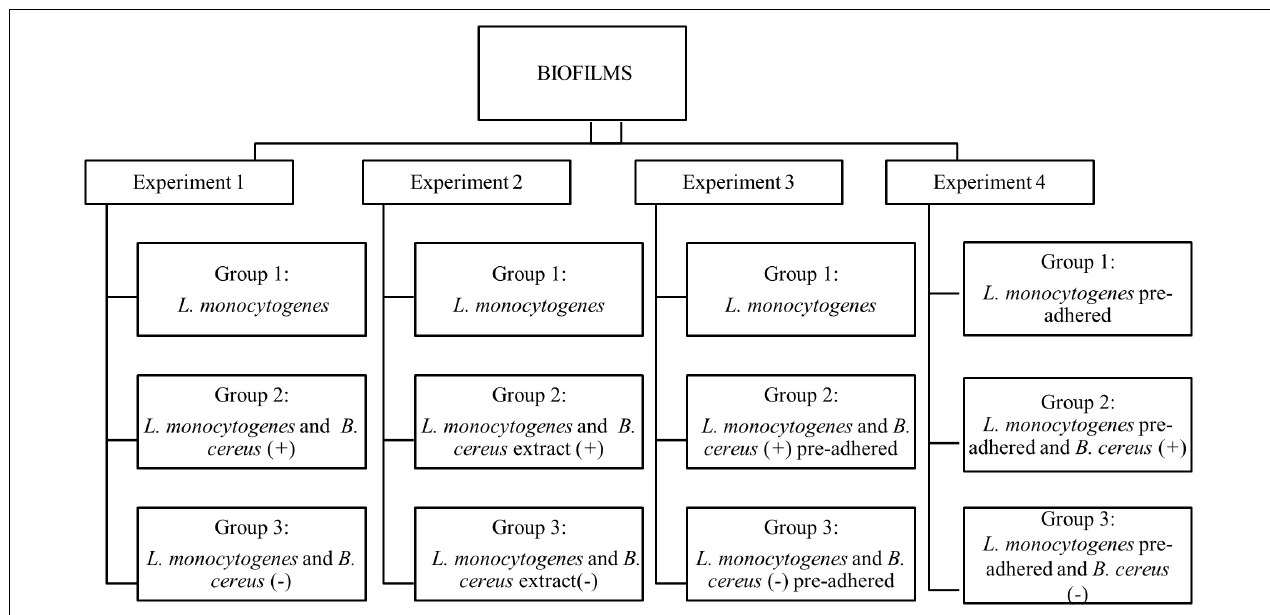
FIGURE 1 | Flowchart of dual-species biofilm formation in stationary culture on stainless steel surface in BHI kept at 25 ◦ C. B. cereus producer of antagonist substance (+) and B. cereus non-producer antagonist substances (–).